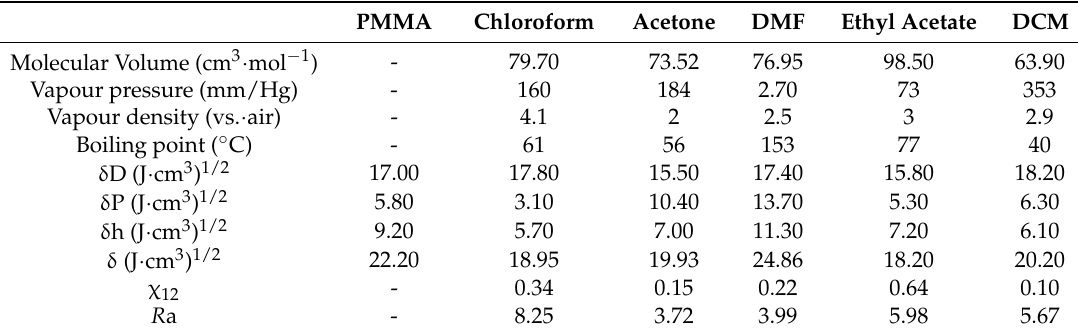
Table 1. Physical properties of PMMA and solution parameters of solvents used in this study. δ and χ values were obtained from reference [36]. PMMA